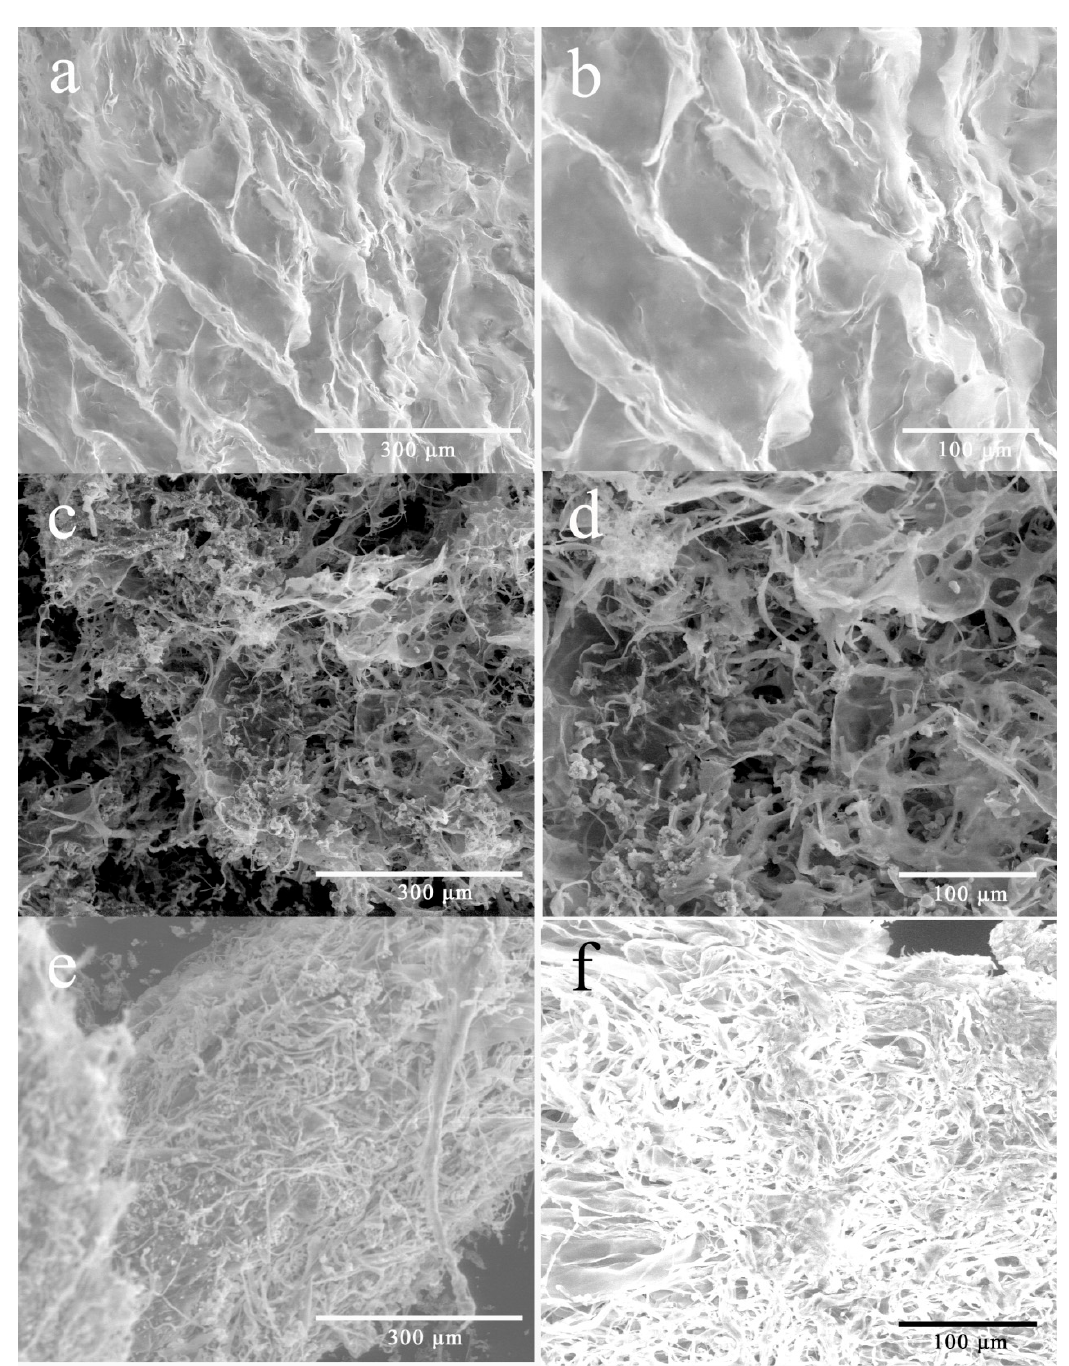
Figure 4. Environmental scanning electron microscopy images of WEP and its fractions. ( a ) WEP ( × 400); ( b ) WEP ( × 800); ( c ) WEP-0.3 ( × 400); ( d ) WEP-0.3 ( × 800); ( e ) WEP-0.4 ( × 400); ( f ) WEP-0.4 ( × 800).